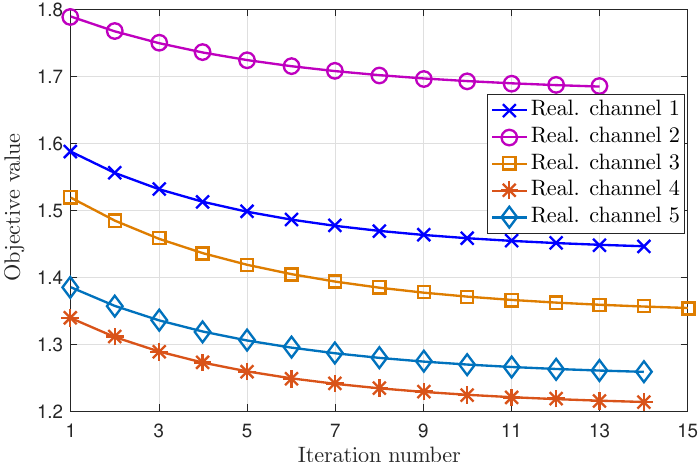
Figure 3. The convergence of the proposed iterative algorithm with the penalty function, as detailed in Algorithm 1.